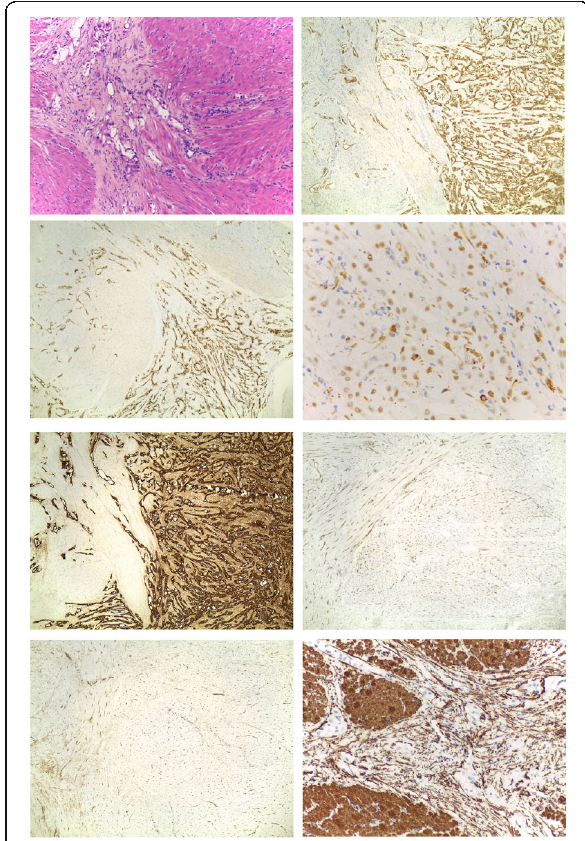
Fig. 2 Second case of leiomyoadenomatoid tumor. The HE staining showed an equivalent morphological pattern to the first case (10x and 40x). Immunohistochemical study revealed positivity for SMA (40x), Calretinin, D2 – 40, WT1, and cytokeratin (10x). The image shows a low proliferative KI-67 index